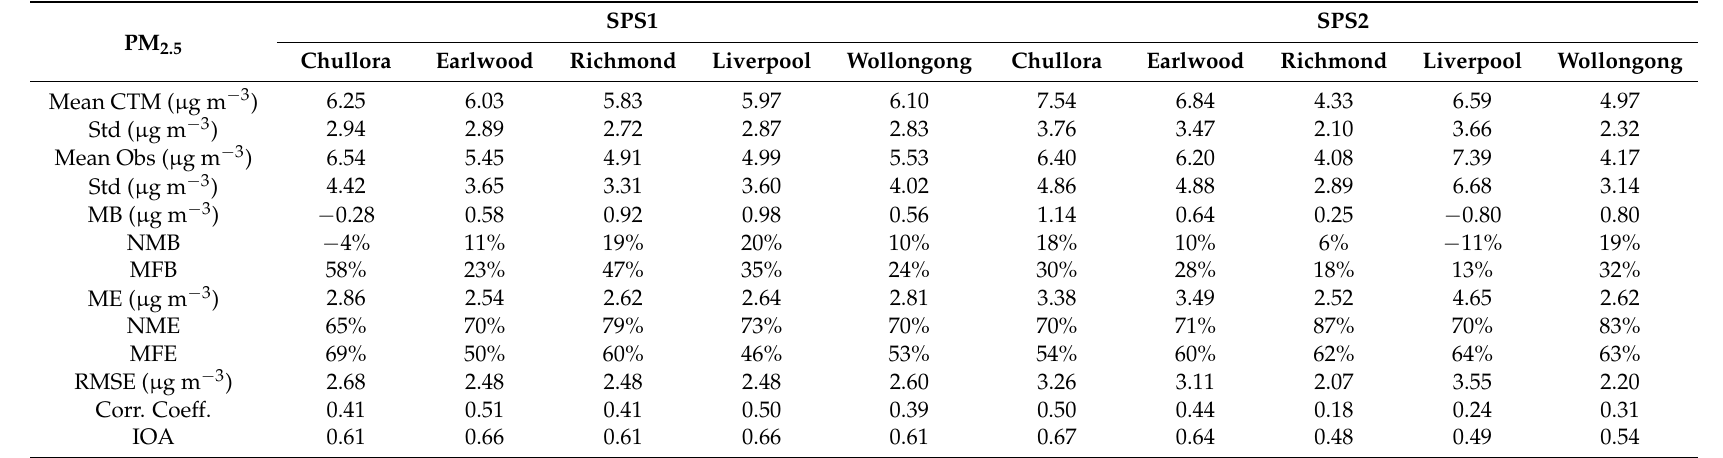
Table 2. Quantitative performance statistics for predicted hourly PM 2.5 concentration against observations at Chullora, Earlwood, Richmond, Liverpool and Wollongong for the periods of SPS1 and